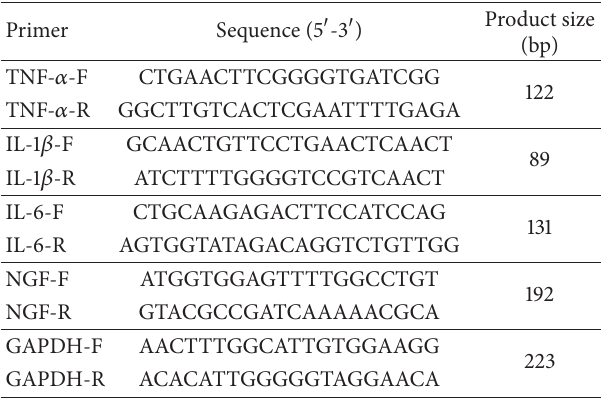
Table 1: Sequences of the primers used in this